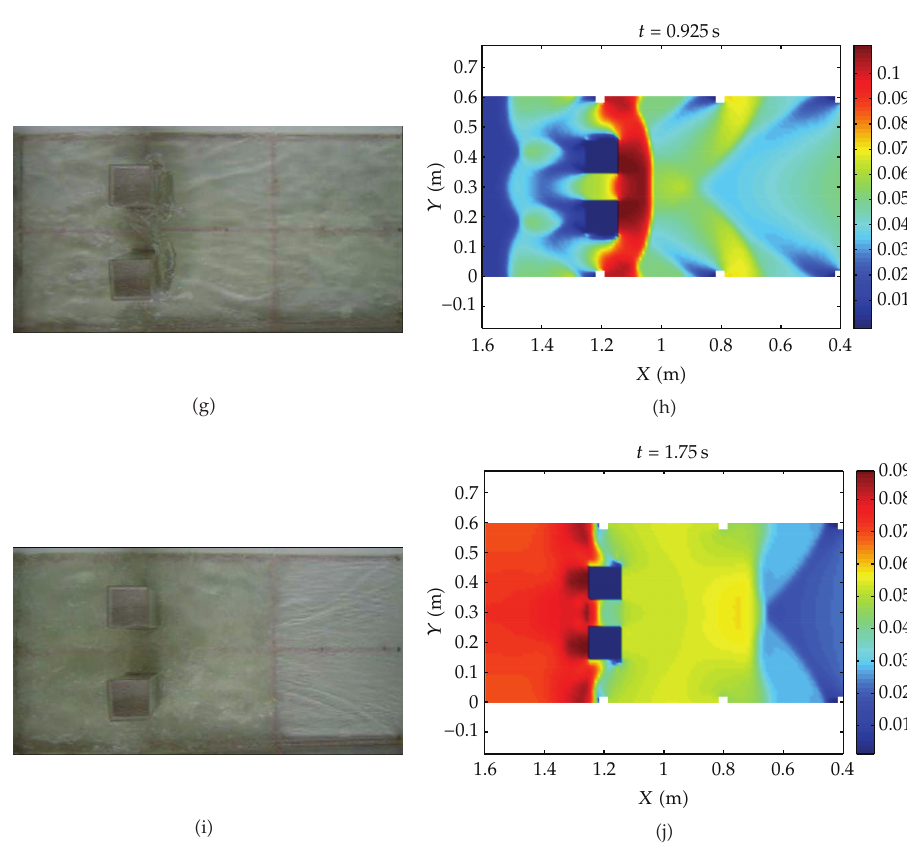
Figure 5: Comparisons of experiments and numerical simulations— (cid:5) a (cid:6) and (cid:5) b (cid:6) when t (cid:9) 0 . 56sec, dam- break flow arrives to the columns; (cid:5) c (cid:6) and (cid:5) d (cid:6) when t (cid:9) 0 . 625sec, dam-break flow moves to the middle of the columns; (cid:5) e (cid:6) and (cid:5) f (cid:6) when t (cid:9) 0 . 725sec, dam-break flow surrounds the columns and forms vortexes; (cid:5) g (cid:6) and (cid:5) h (cid:6) when t (cid:9) 0 . 925sec, dam-break flow touches the boundary of tank; (cid:5) i (cid:6) and (cid:5) j (cid:6) when t (cid:9) 1 . 75sec, the flow returns to the location of